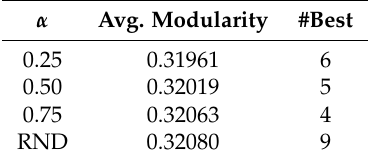
Table 3. Results obtained by the GRASPAGG algorithm considering different values for α